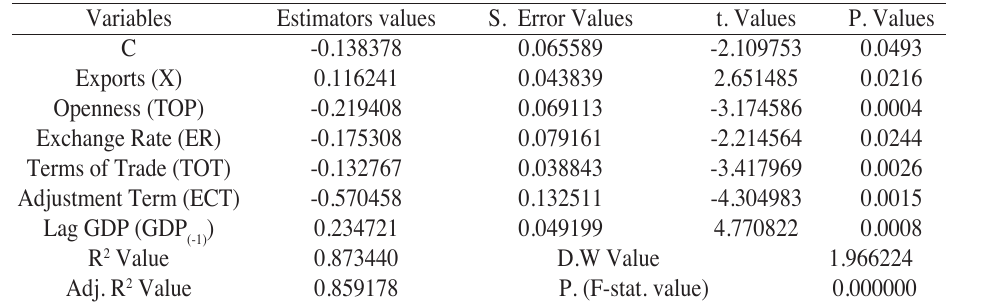
Table 2: ARDL Analysis of Variables (variables are in